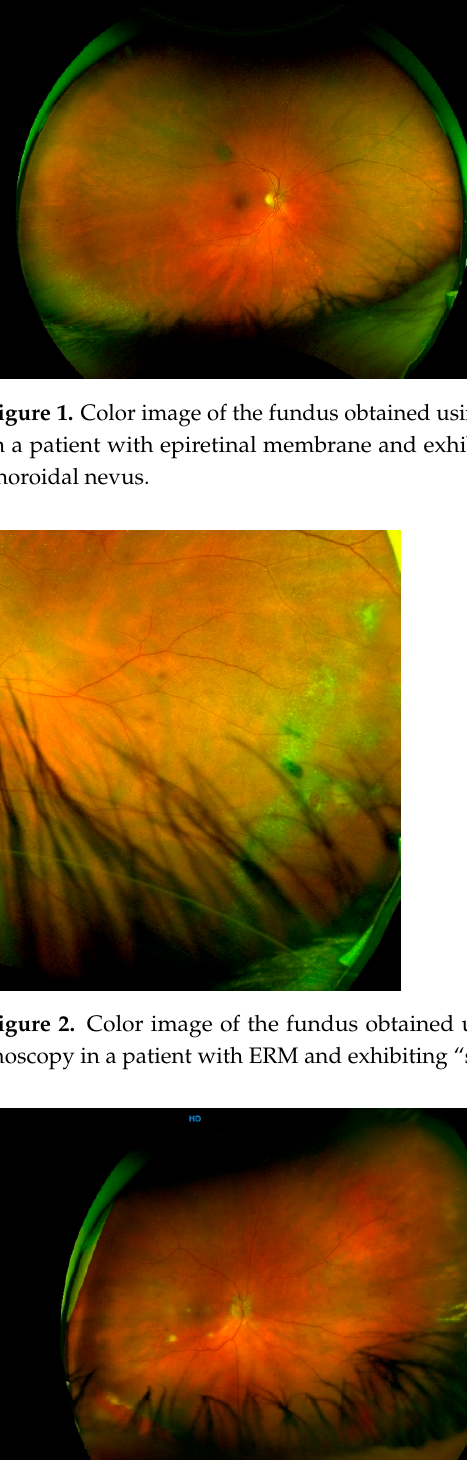
Figure 3. Retinal break—a severe degenerative lesion of the peripheral retina.